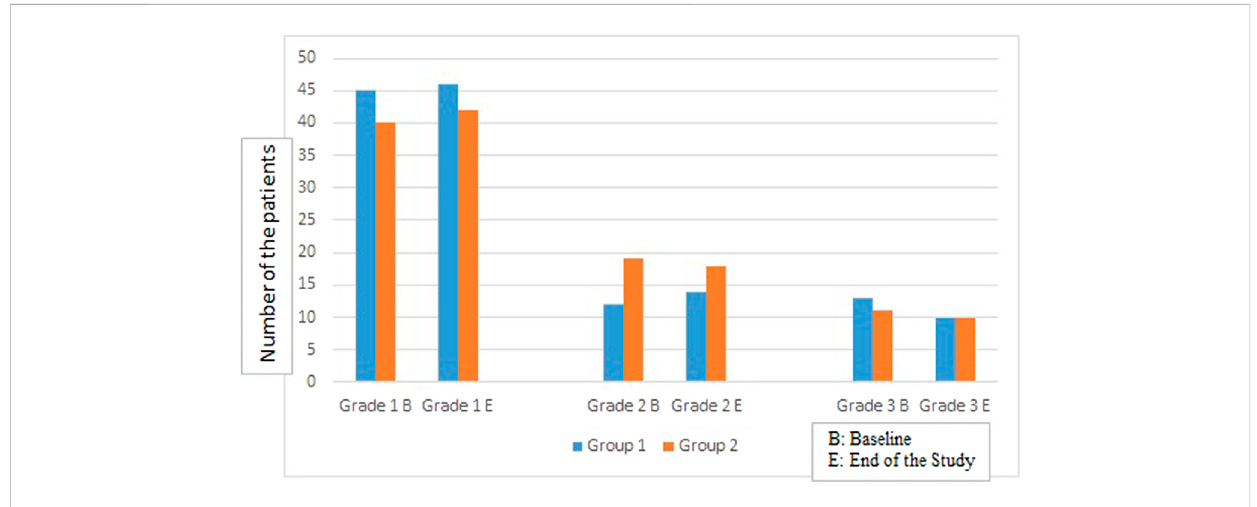
FIGURE 2 Comparison of the number of patients in both groups in different liver steatosis grades at baseline and at the end of the study.